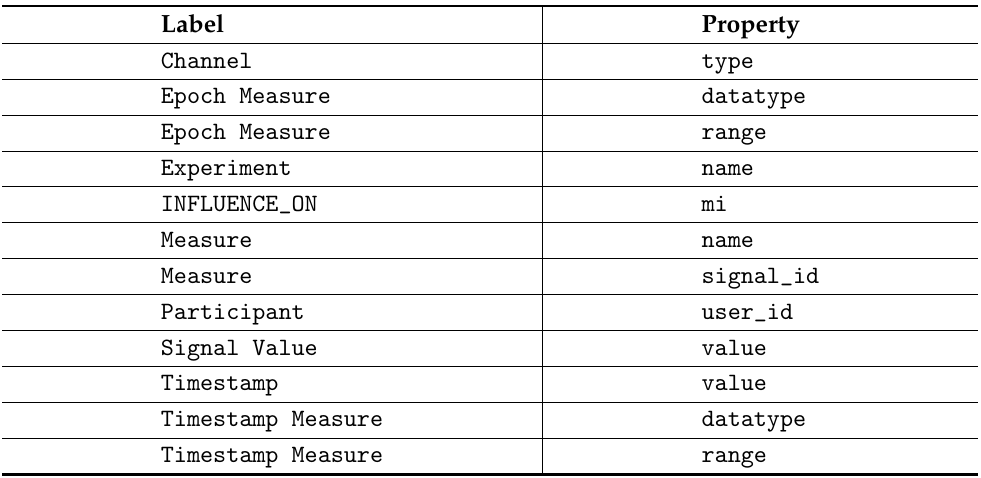
Table A4. Mandatory properties ICs.